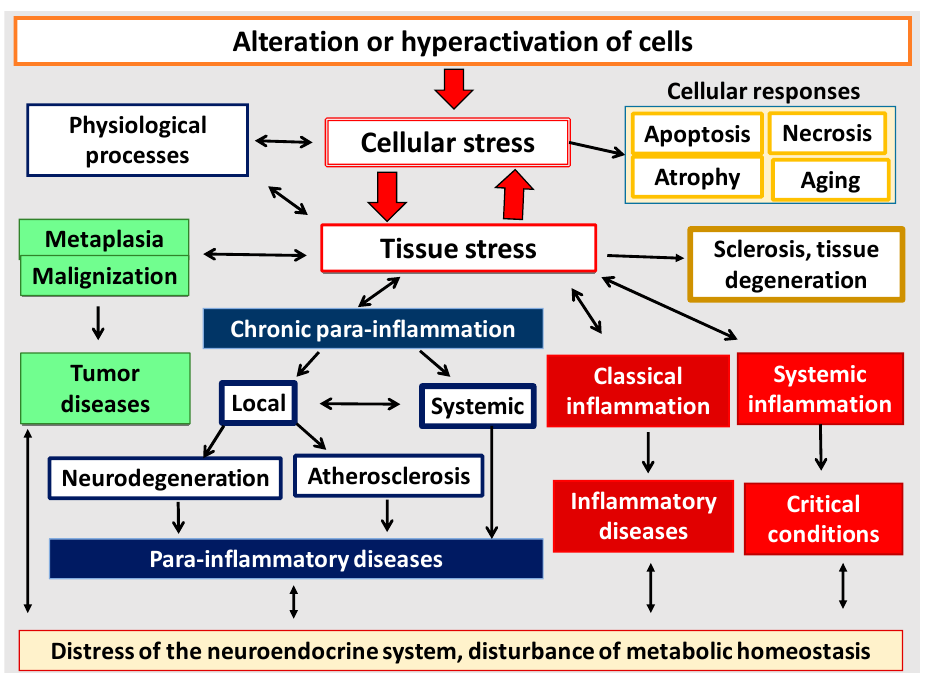
Figure 9. A principal system for the relationships between tissue pro-inflammatory stress and key general pathological processes.